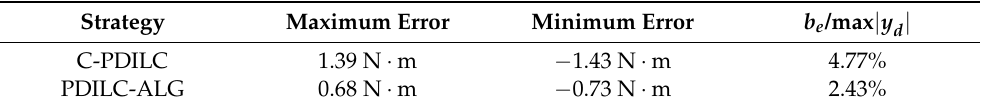
Table 6. Case 2 ( θ ∗ a ( t ) = 4 ◦ sin ( 4 π ih ) , y d ( t ) = 30sin ( 4 π ih ) ) experimental results of the two